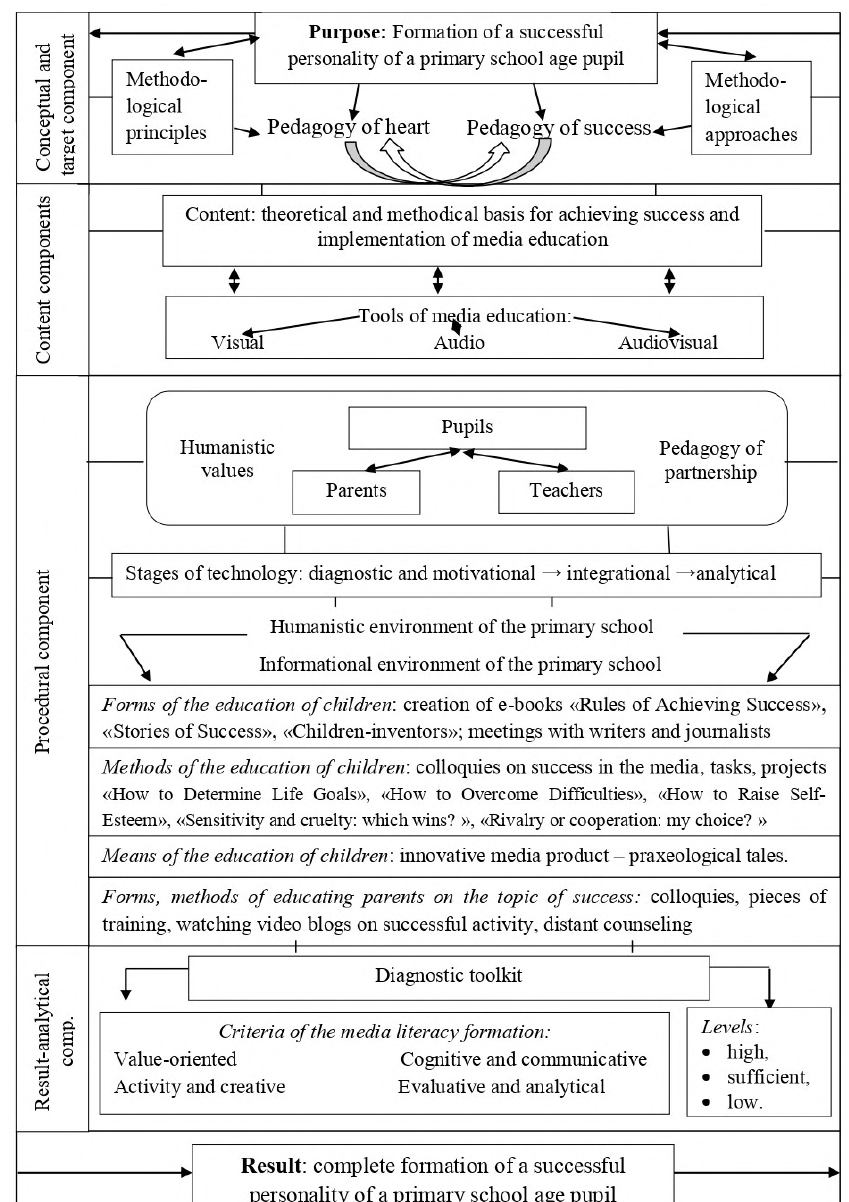
Figure 37: Presentation of paper